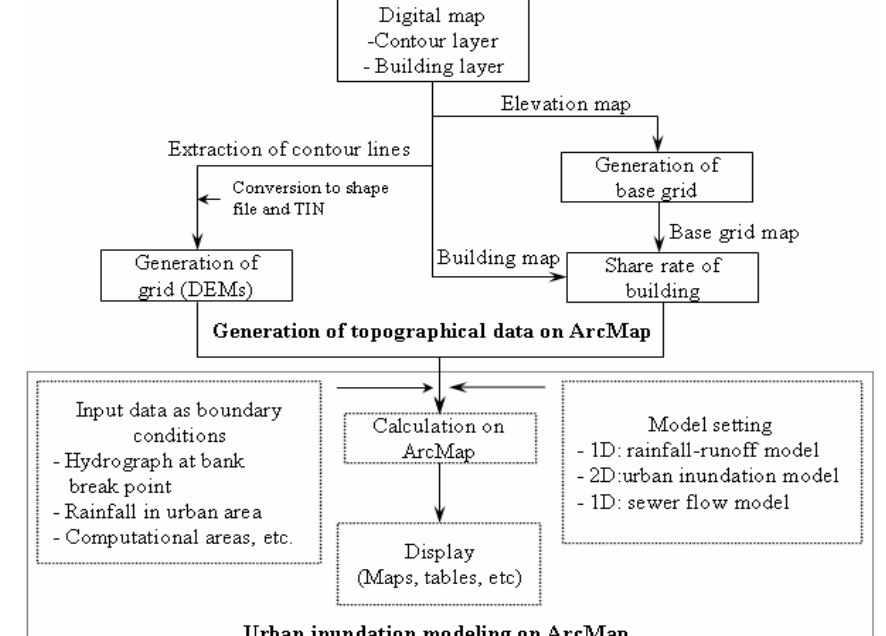
Fig. 1. Urban flood model structure on ArcGIS